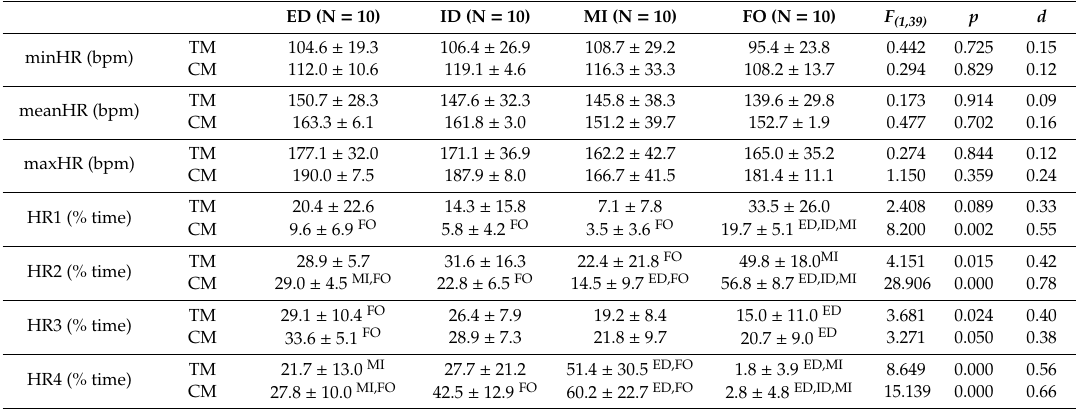
Table 3. One-way ANOVA of physiological responses of soccer players in TM and CM according to the playing